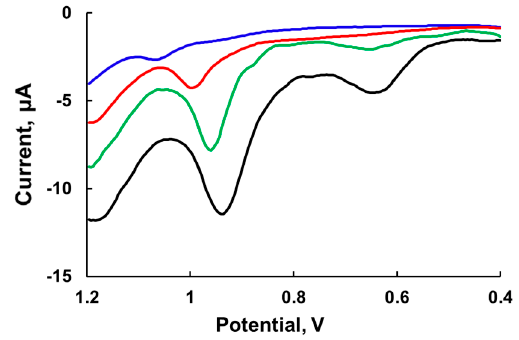
Figure 4. Differential pulse voltammetry curves of 1.0 mM Ru 4 POM in 80 mM sodium borate buffer at pH 8.0 at varying concentrations of NaNO 3 : 0.15 M (blue), 0.25 M (red), 0.5 M (green), and 0.75 M (black). Differential pulse voltammetry (DPV) parameters: V (mV/s) = 20, sample width (ms) = 17, pulse amplitude (mV) = 50, pulse width (ms) = 50, pulse period (ms) = 200, quiet time (s) = 2.